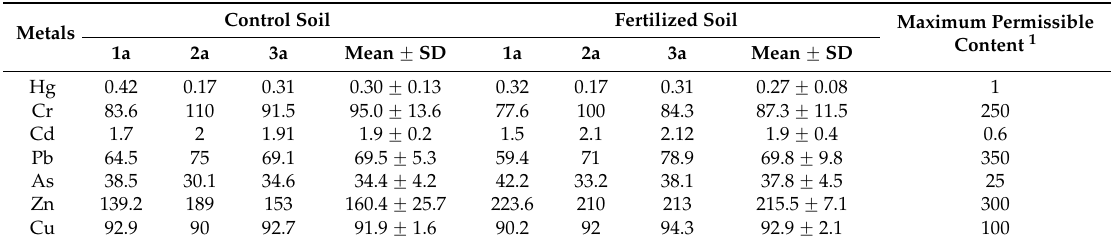
Table 4. Contents of heavy metals in different soils (unit: mg ¨ kg ´ 1